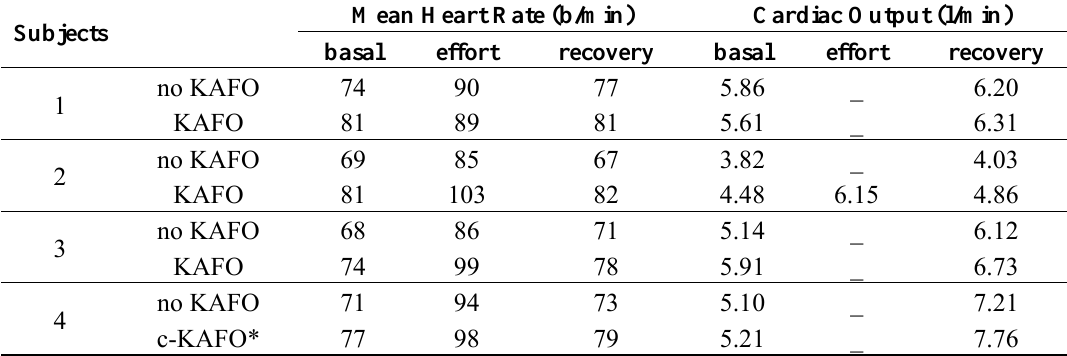
Table 3. Mean values of the ECG/ICG parameters measured under different trial conditions. Mean Heart Rate (b/min) Cardiac Output (l/min) Subjects basal effort recovery